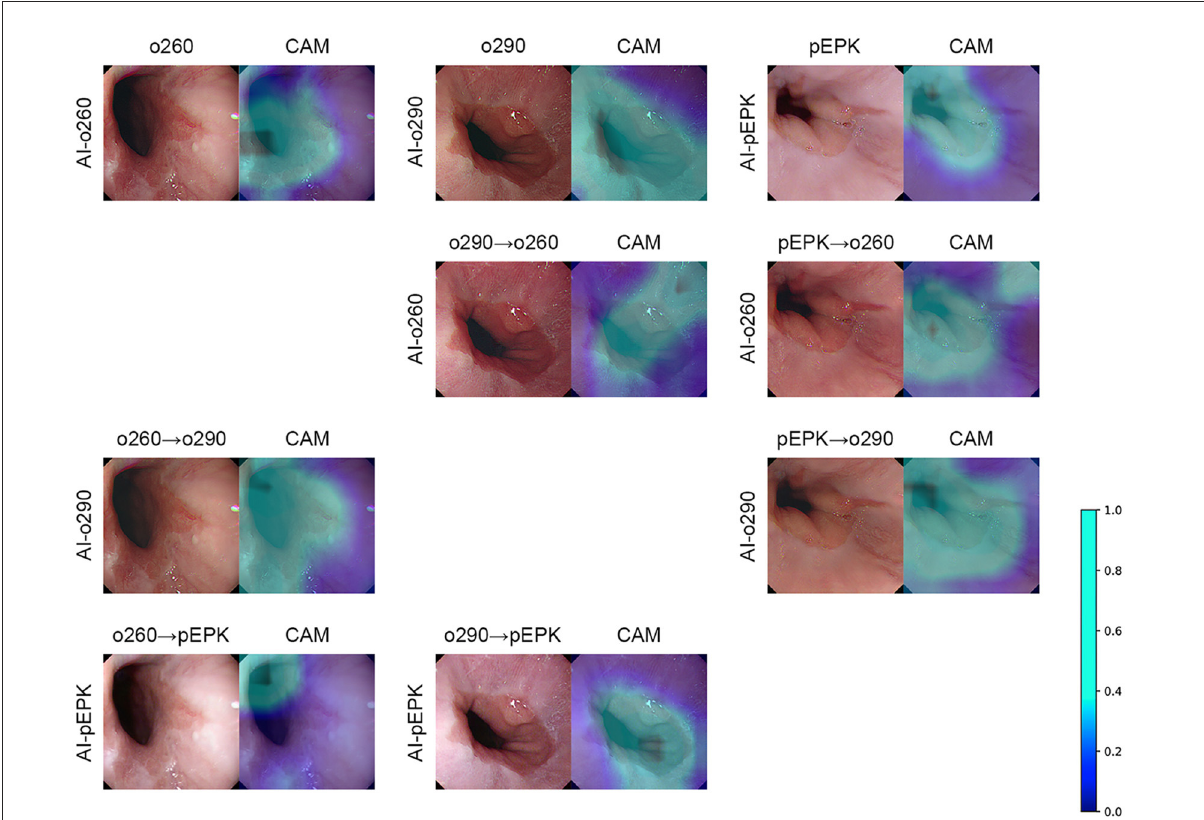
FIGURE5 Examples of CycleGAN transformation and class activation map of EGJ-recognition AI. The AI indicated on the far-left side of the figure generates the CAM based on the endoscopic image placed on the left. As shown in the color scale bar on the right, a light blue color on the CAM denotes a higher significance level. The overlaying result is arranged on the right side of the figure. The figures in the top row are the results of the original endoscope model images. The cycleGAN transformation results are listed in the following three rows. The transformation was performed on the top original images to obtain the image characteristics of the AI indicated on the far-left side of the figure. o260, Olympus CV-260SL; o290, Olympus CV-290; pEPK, PENTAX EPK-i; AI, artificial intelligence; EGJ, esophagogastric junction; CAM, class activation map; GAN, generative adversarial